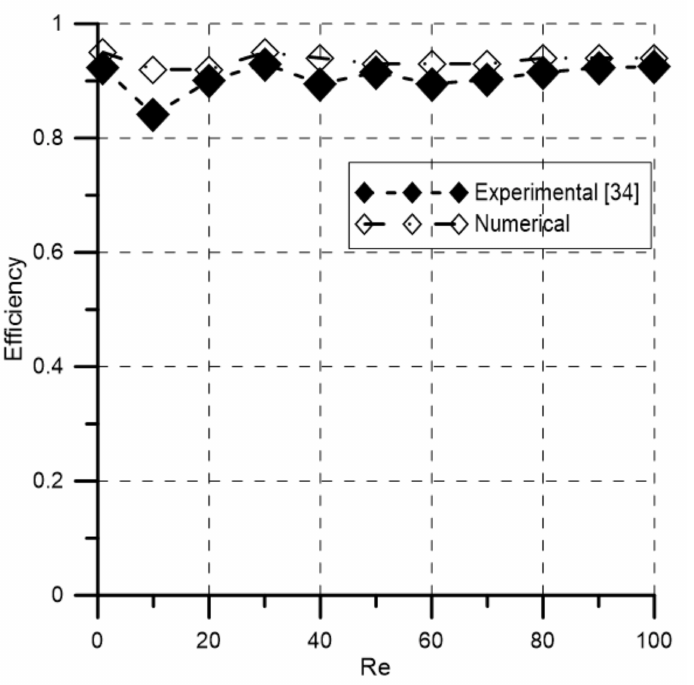
Figure 6. Comparison between experimental efficiency [34] and numerical efficiency of the present study for ‘ H − C ’